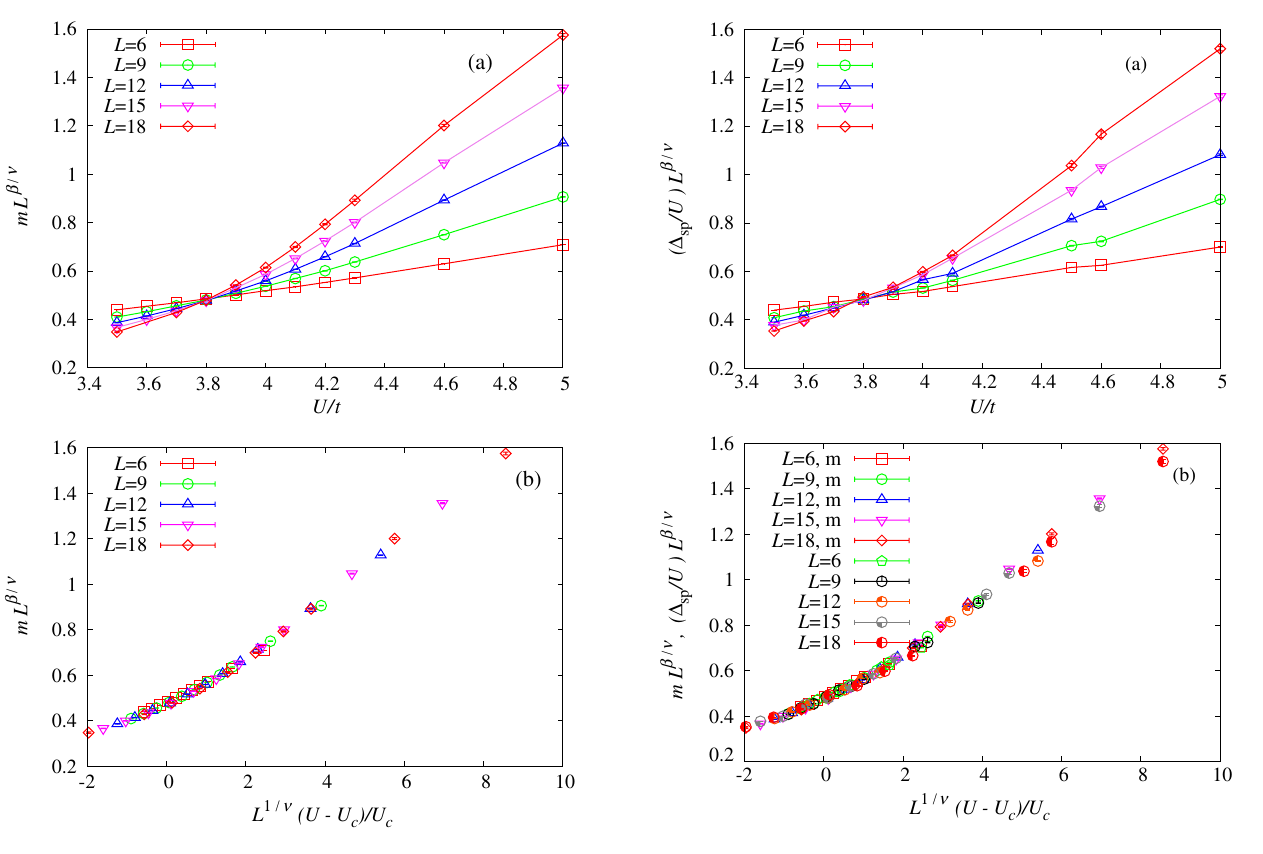
FIG. 5. Data collapse for the magnetization presented in Fig. 3. The exponents are taken for the (cid:8) expansion of Ref. [6]. (a) The crossing point pins down the value of U c . (b) The data collapse, using U c =t ¼ 3 : 78